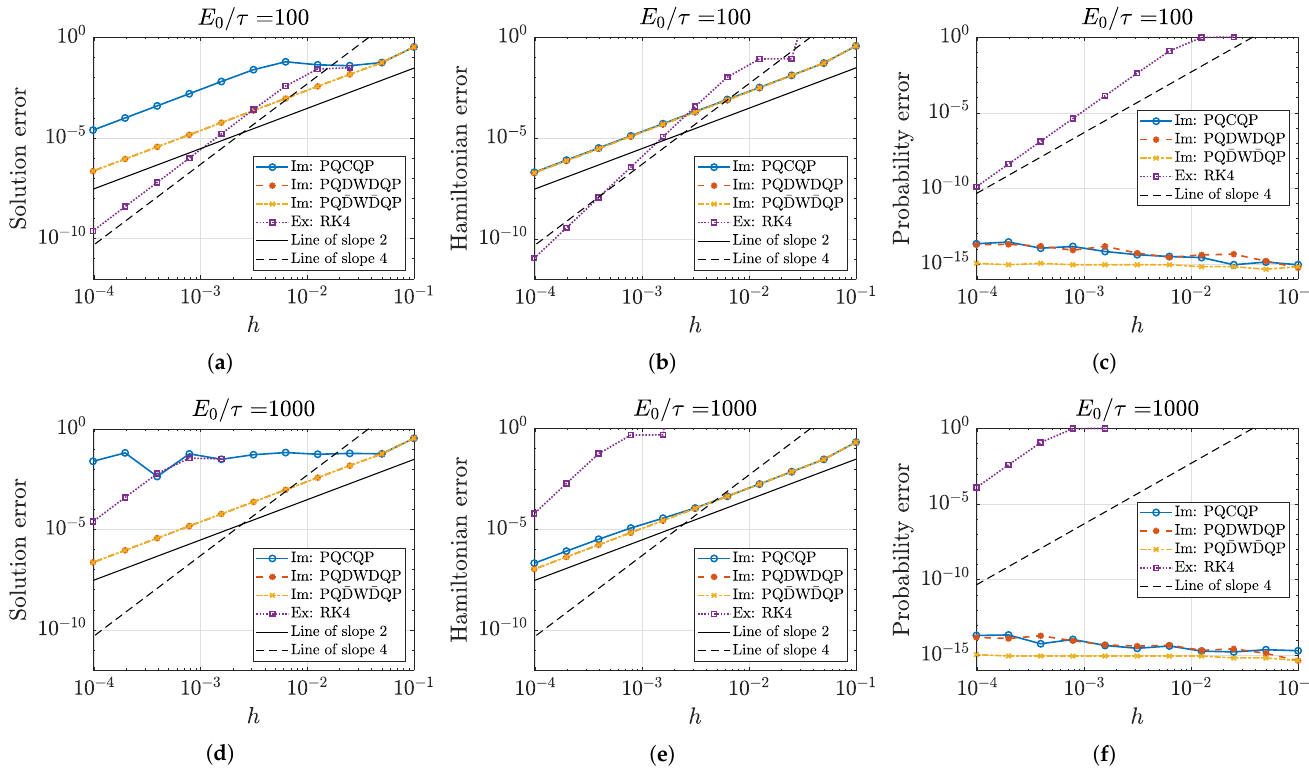
Figure 2. Numerical convergence study of the semi-implicit splitting methods: PQCQP, PQDWDQP, and PQ ¯DW ¯DQP, compared to the fourth-order explicit Runge-Kutta method RK4. Top ( a – c ): E 0 / τ = 100. Bottom ( d – f ): E 0 / τ = 1000. Left ( a , d ): maximal absolute error of the solution at time t = 1. Middle ( b , e ): maximal relative error of the Hamiltonian (42) for t ∈ [ 0,1 ] . Right ( c , f ): maximal relative error of the total charge probability (16) for t ∈ [ 0,1 ] . The numerical solution of reference is computed with the method PQDABADQP and time step h = 10 − 7 and with initial conditions given by the patterns (100) and (101), where γ =